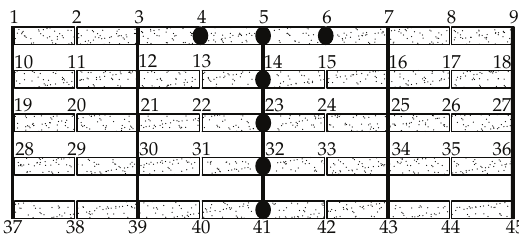
Figure 6: Characteristic nodes for the damage identification of element 4.